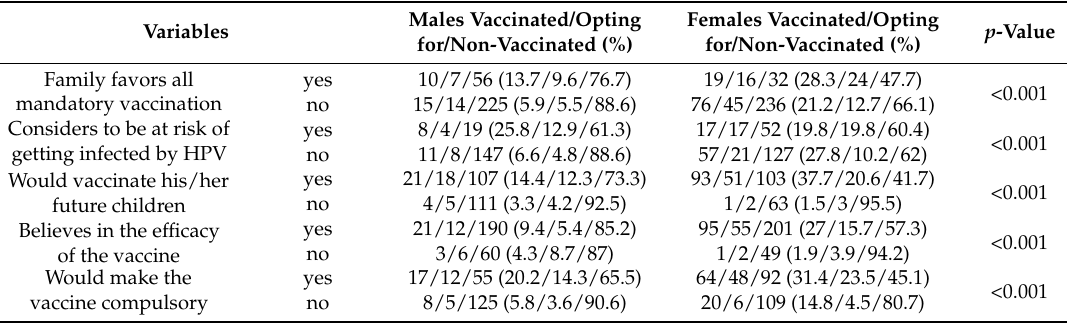
Table 10. Attitudes toward HPV vaccination based on vaccination